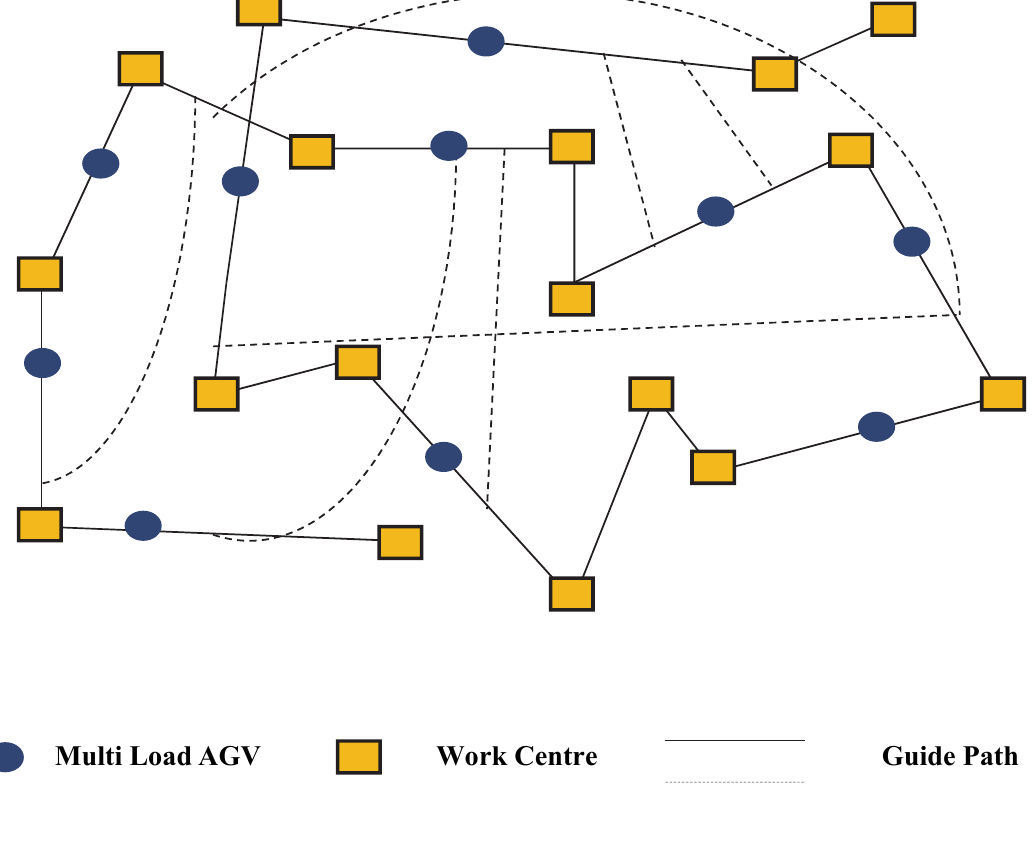
Fig. 1. Configuration of AGVs and work